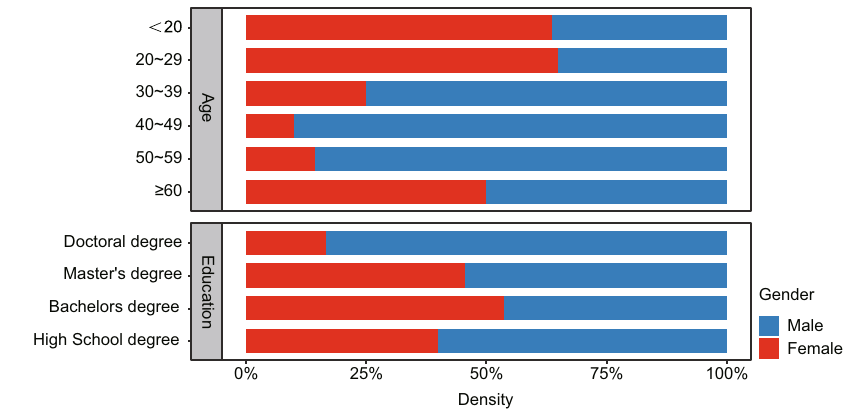
Fig. 3 Participants ’ age and education